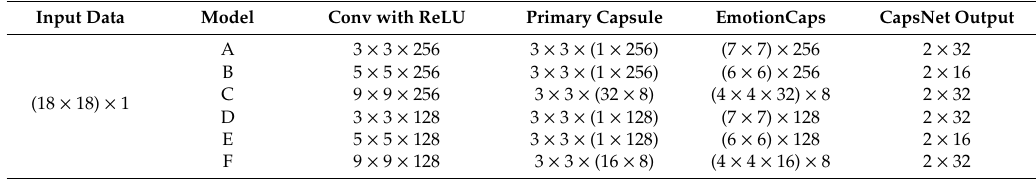
Table 3. Six CapsNet-based models (A, B, C, D, E, and F) with different parameters in the second